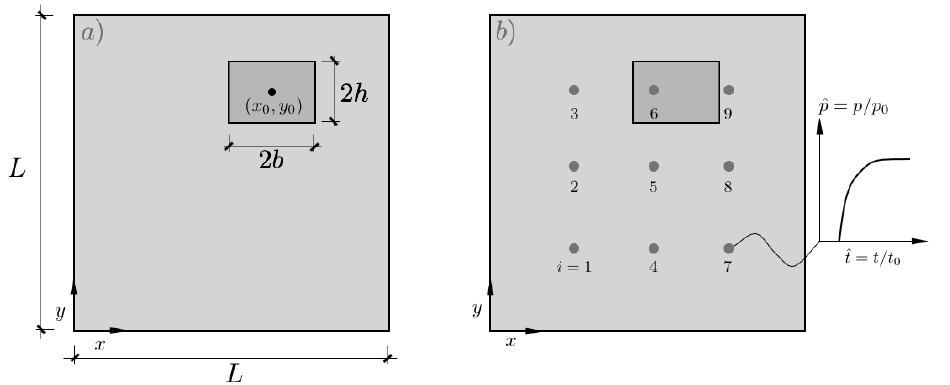
Figure 2. ( a ) Definition of the model containing a dissimilar rectangular region with center coordinates ( x 0 , y 0 ) , size 2 b 2 h and permeability K = β K 0 , ( b ) 3 × distributed on the mould surface.